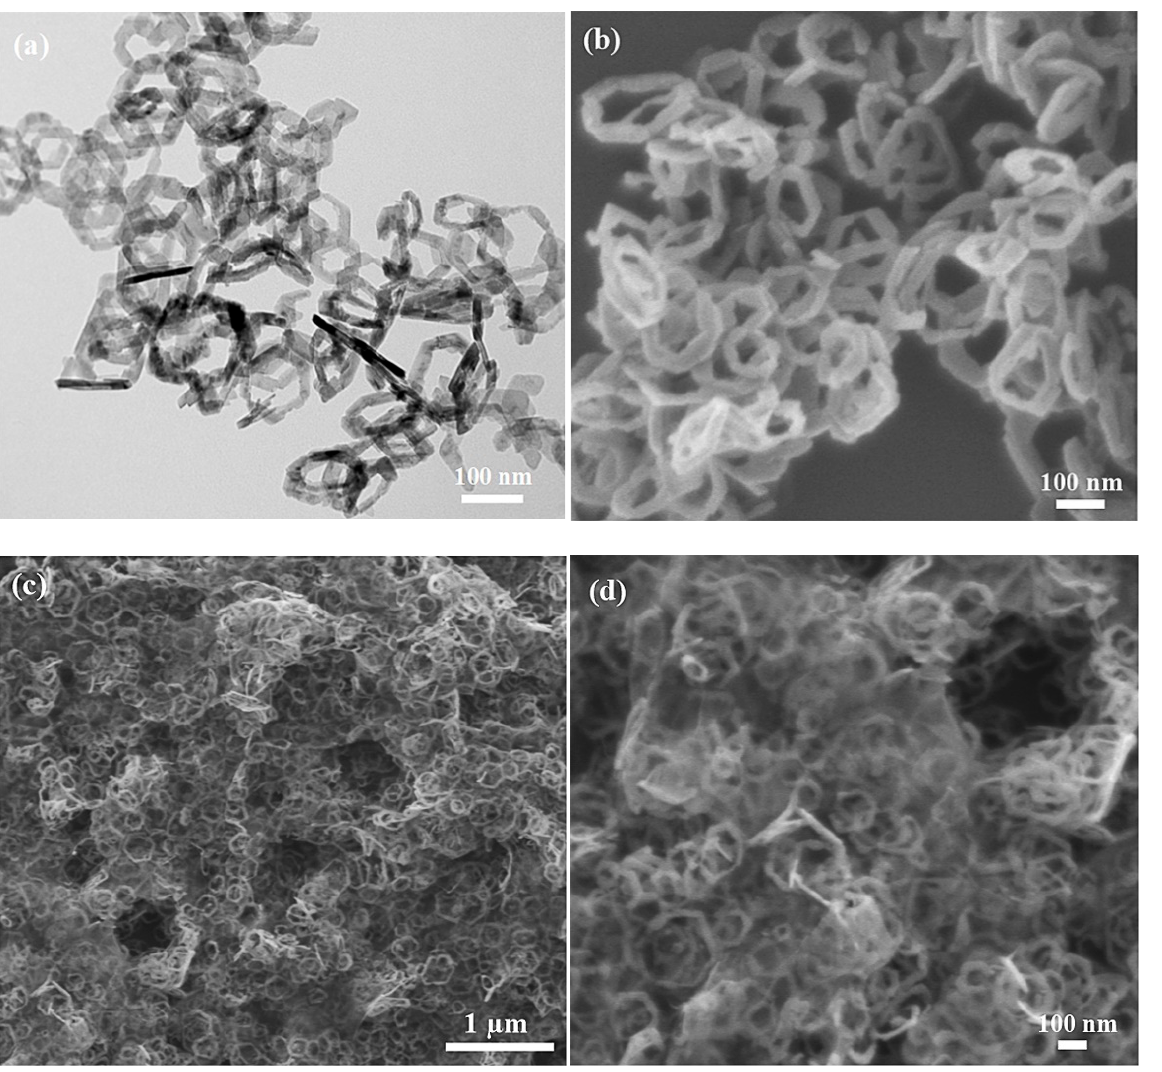
Figure 2. ( a ) TEM and ( b ) SEM images of pure CoOOH. ( c , d ) SEM images of CoOOH/rGO at dif- ferent magnifications. ( e , f ) TEM images of CoOOH/rGO at ( e ) low magnification and ( f ) high magnification. The nitrogen adsorption–desorption isotherms and BJH adsorption pore size dis- tributions of pure CoOOH and CoOOH/rGO nanocomposite are plotted in Figure 3. Type IV isotherms (IUPAC classification) are present for both pure CoOOH and CoOOH/rGO nanocomposite, indicating their mesoporous characteristics (Figure 3a) [43]. The pure CoOOH exhibits an H 1 -type hysteresis loop, which is related to the capil- lary condensation inside the mesopores, indicating the existence of mesoporous struc- ture. An H 2 hysteresis loop was observed for CoOOH/rGO nanocomposite, implying its complex pore structure. In addition, the hysteresis loop of CoOOH/rGO is significantly larger than that of pure CoOOH, suggesting the increased amount of pores in the nano- composite [44]. It is thus likely that some of the pores in the nanocomposite were gener- ated by the voids of aggregated particles, given that many of the CoOOH nanorings were wrapped together by rGO nanosheets. The pore size distribution derived from the ad- sorption branch of pure CoOOH shows a broad distribution, ranging from 1.7 nm to 61.9 nm, while that of CoOOH/rGO nanocomposite is broader, ranging from 1.9 nm to 93.6 nm (Figure 3b). The specific surface area, pore volume and pore diameter of pure CoOOH and CoOOH/rGO nanocomposite based on BET method are depicted in Table 1. The BET specific surface areas of pure CoOOH and CoOOH/rGO nanocomposite are 72.6 and 68.2 m 2 ·g − 1 , respectively. The slight decrease in the nanocomposite specific surface area may be due to the stacking, coating and curling between CoOOH nanorings and rGO nanosheets. The pore volume of CoOOH/rGO nanocomposite is larger than that of pure CoOOH (being 0.34 and 0.29 cc·g − 1 , respectively), which is consistent with more pores in the nanocomposite. Moreover, the average pore diameters of pure CoOOH and